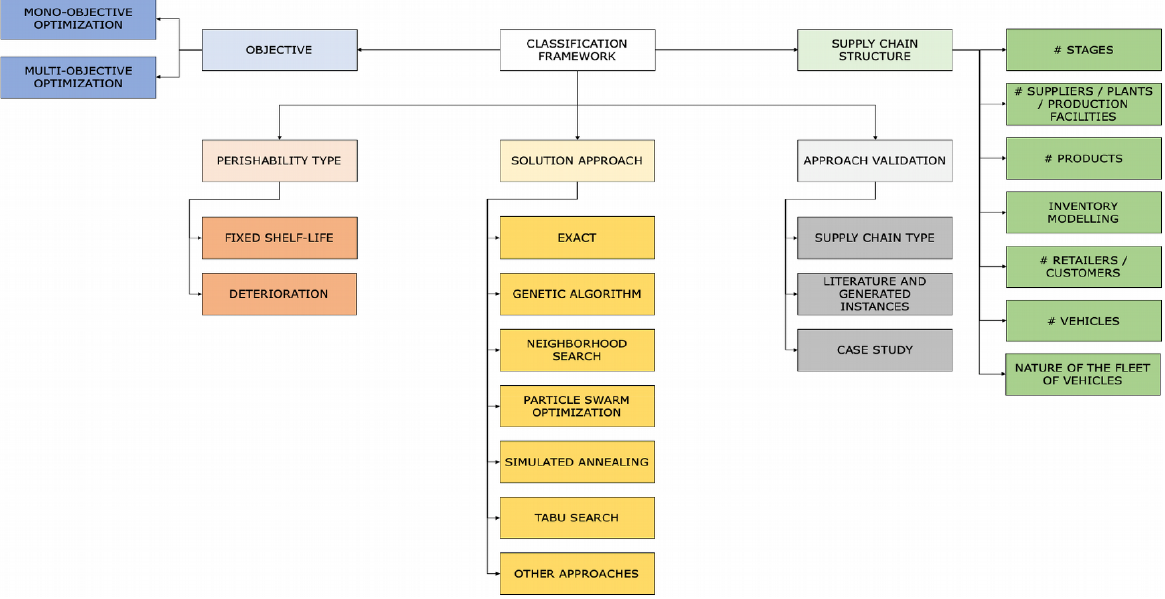
Figure 4. Classification